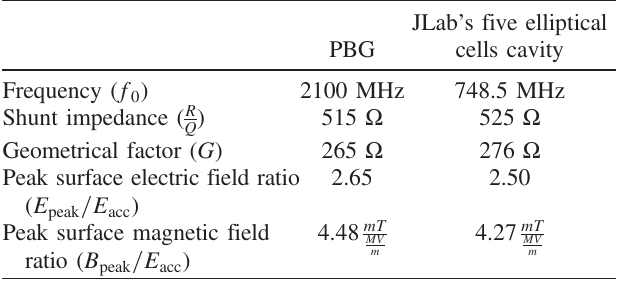
TABLE II. Accelerating properties of the five-cell cavity with a PBG cell compared to the accelerating properties of the cavity with five elliptical low-loss cells from Ref.